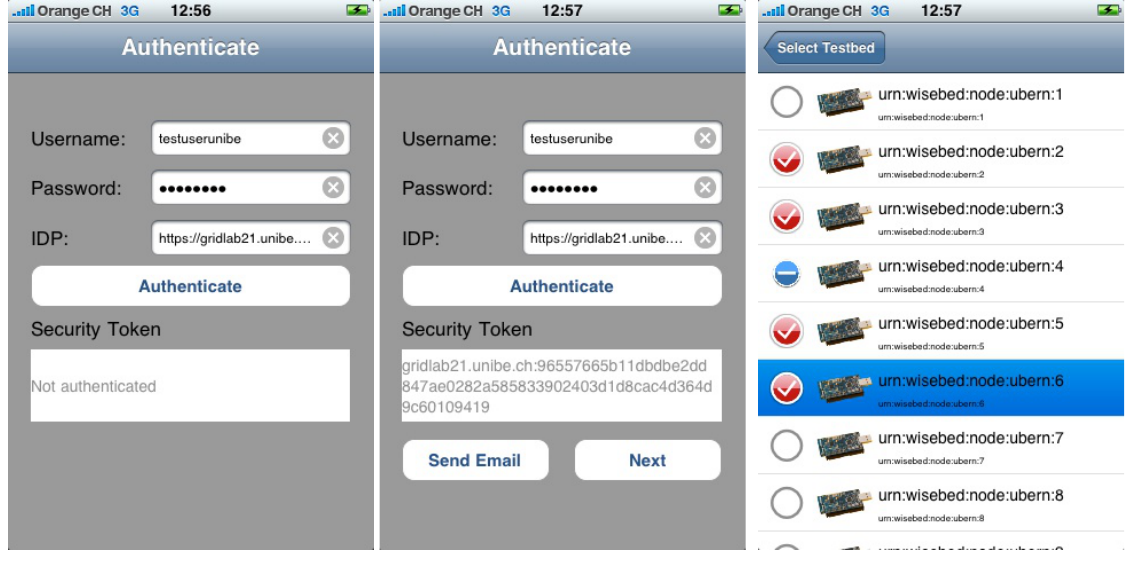
Figure 10. Screenshots of the iPhone application (authentication, authentication response, and node